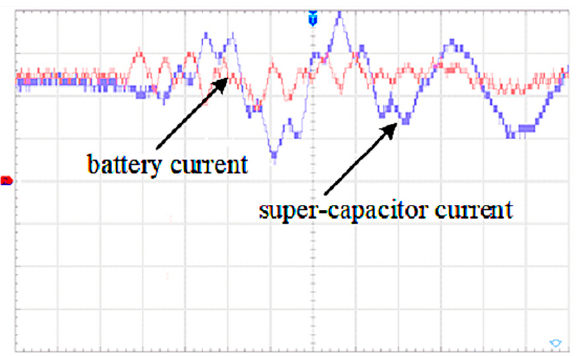
Figure 22. Motor controller current when climbing with constant speed.